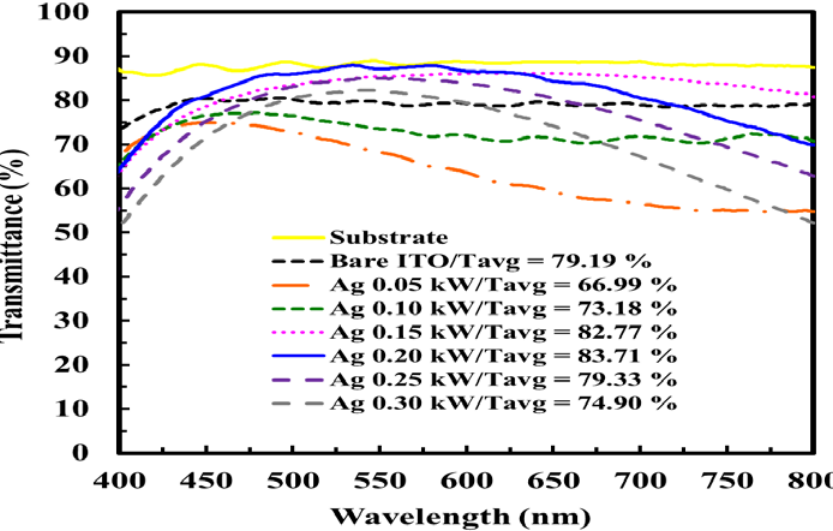
Figure 3. The average optical transmittance spectrum of the continuously grown ITO (42 nm)/nano- Ag/ITO (42 nm) multilayers correspond to different Ag DC powers (from 0.05 to 0.30 kW).